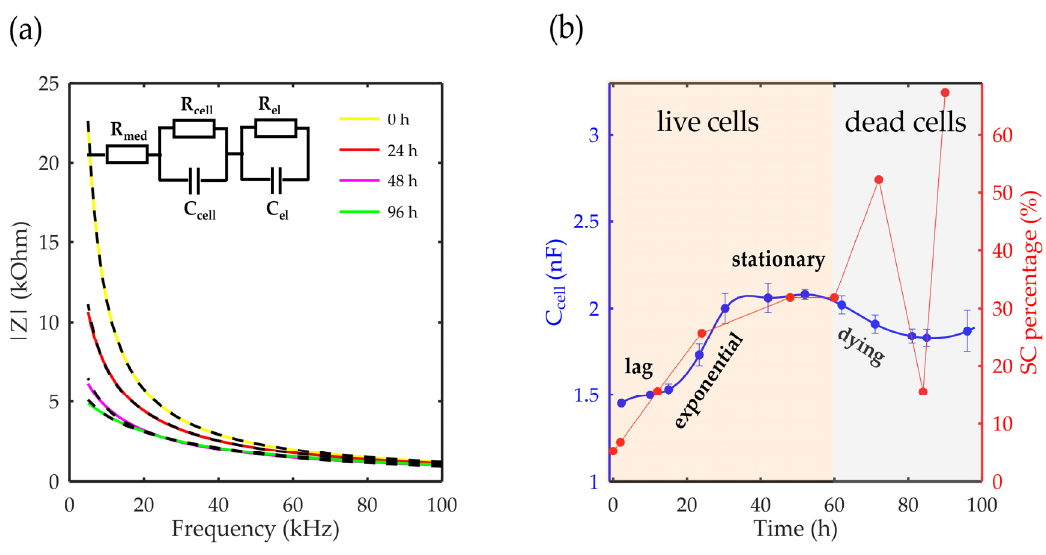
Figure 5. Fitting results: ( a ) The impedance module in the function of frequency for 0, 24, 48, and 96 h of cultivation. The black curves represent the fitted results, with the equivalent circuit presented in the inset. ( b ) Cell capacitance in the function of the cultivation time compared with the image processing results. The error bars in the graph represent the standard deviations of the equivalent circuit model and the image processing from images at three di ff erent places in the microbioreactor.